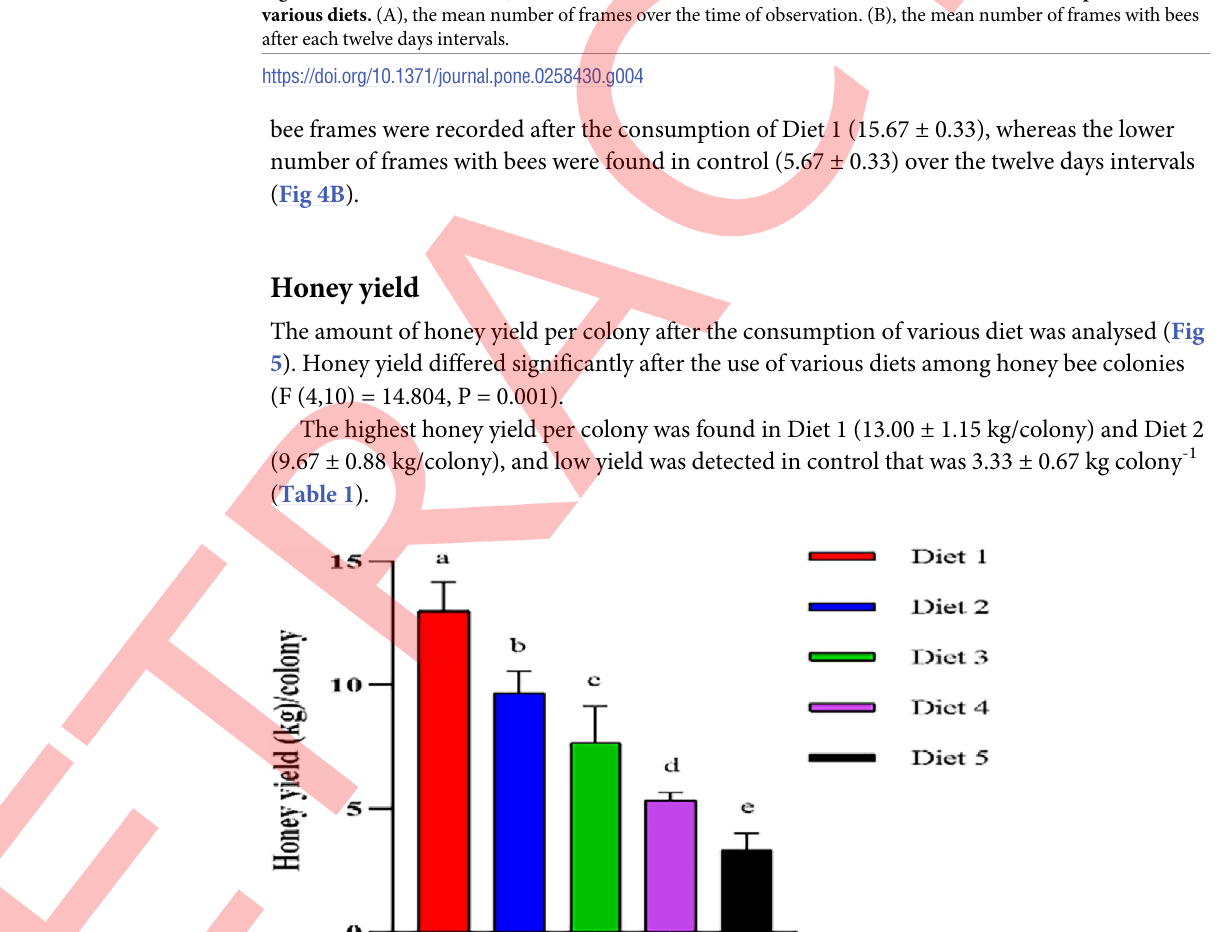
bee frames were recorded after the consumption of Diet 1 (15.67 ± 0.33), whereas the lower number of frames with bees were found in control (5.67 ± 0.33) over the twelve days intervals